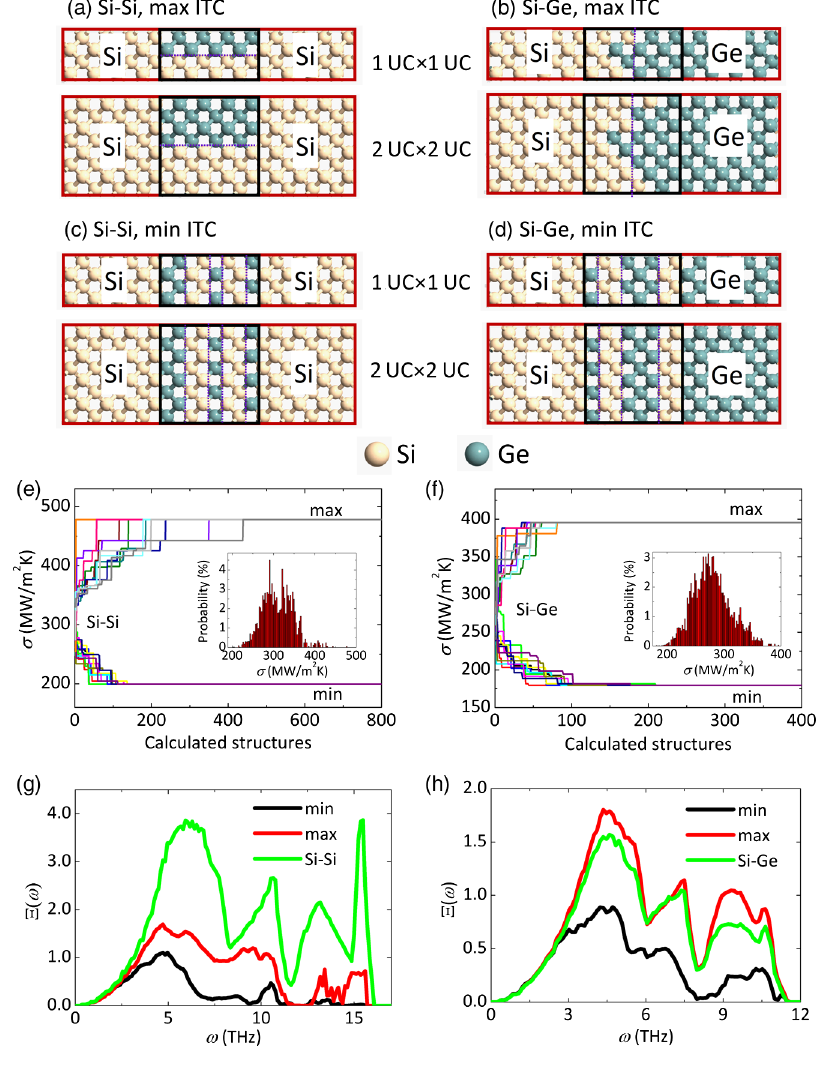
FIG. 2. Interfacial Si = Ge alloy structure optimization. (a) – (d) Optimal structures with the maximum and minimum interfacial thermal conductance (ITC) for Si-Si and Si-Ge interface with different sizes of supercell cross section ( 1 UC × 1 UC and 2 UC × 2 UC). The thickness of the interfacial region is 1.1 nm. (e),(f) The 10 optimization runs with different initial choices of candidates, where the insets show the probability distributions of ITC obtained from calculations of all the candidates. (g),(h) Phonon transmission functions of the optimized interfacial structure (maximum and minimum ITC) and bare Si-Si (i.e., no interfacial structure) and Si-Ge